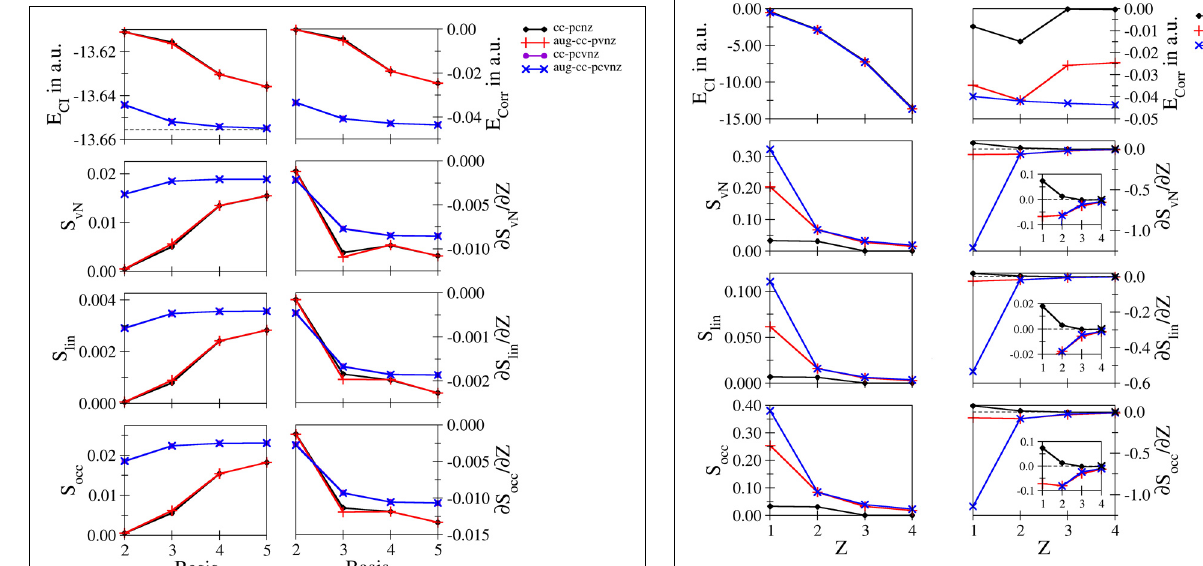
FIGURE 4 | Total and correlation energy E CI and E corr in atomic units; von Neumann S vN , linear S lin and occupation number S occ entropies and their derivative with respect to the nucleic charge Z obtained for Be 2 + at the FCI level using different basis sets.